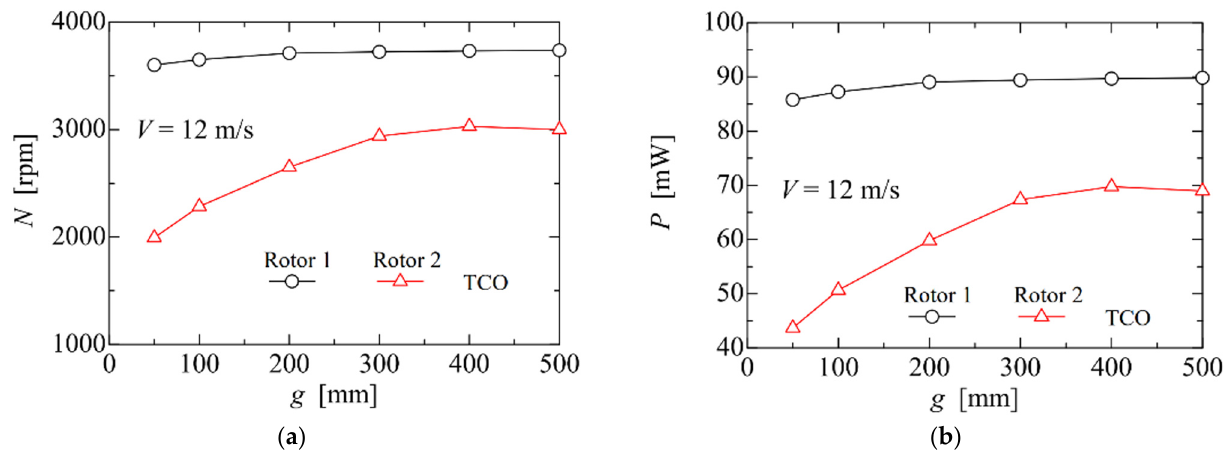
Figure 11. Gap dependence of ( a ) rotational speed and ( b ) power in the TCO layout at V = 12 m/s. Next, we examine the normalized rotational speed N norm , defined in Equation (2).